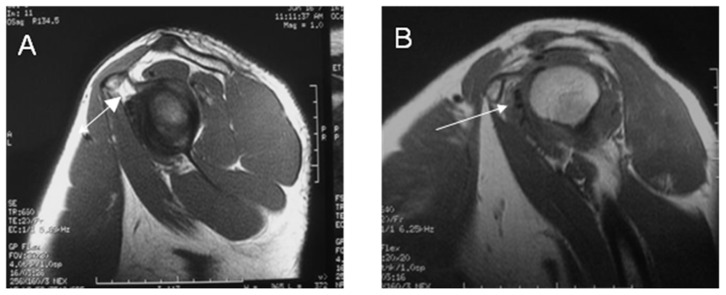
Sagittal oblique TIWI images of subcoracoid fat triangle in control subject and a 55-year-old patient with AC.(A) Normal subcoracoid fat triangle in control subject; (B) Partial obliteration of subcoracoid fat triangle.